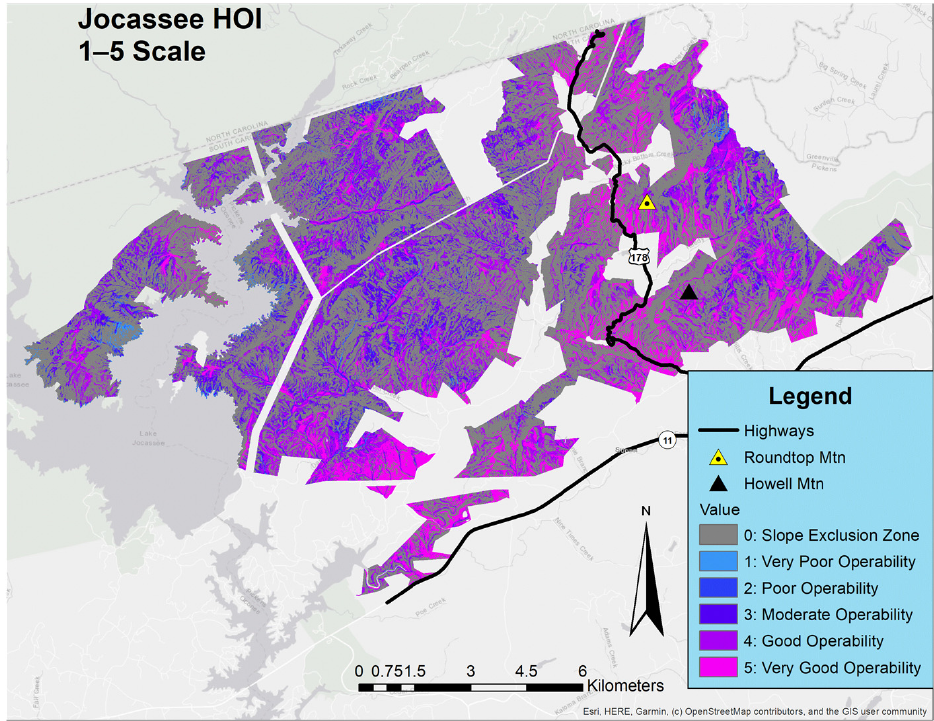
Figure 4. Output of the HOI Model on a 0–24 Scale for Jocassee. Observed scores for the HOI model were 3–23.